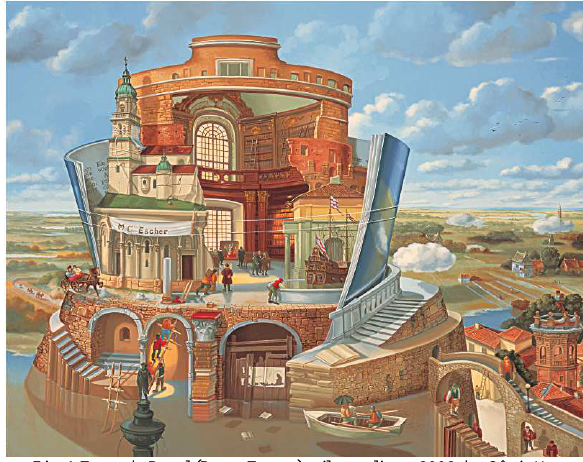
Fig. 1 Torre de Papel (Paper Tower), oil over linen, 2002, by Sônia Menna